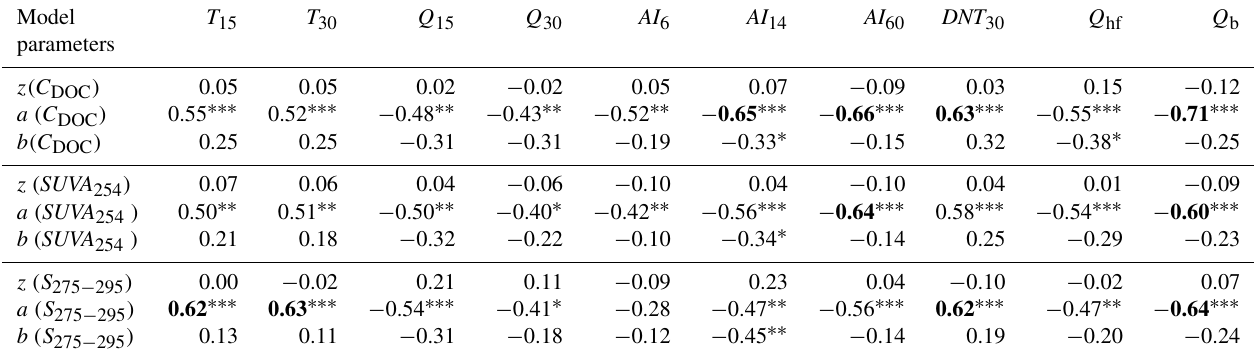
Table 3. Spearman’s rank correlation coefficient ( r s ) of the 38 C DOC , SUVA 254 and S 275 − 295 model coefficients with hydroclimatic variables. Asterisks indicate p values ( ∗∗∗ : <0.001; ∗∗ : <0.01; ∗ : <0.05). r s with absolute values larger than 0.6 are printed in bold.